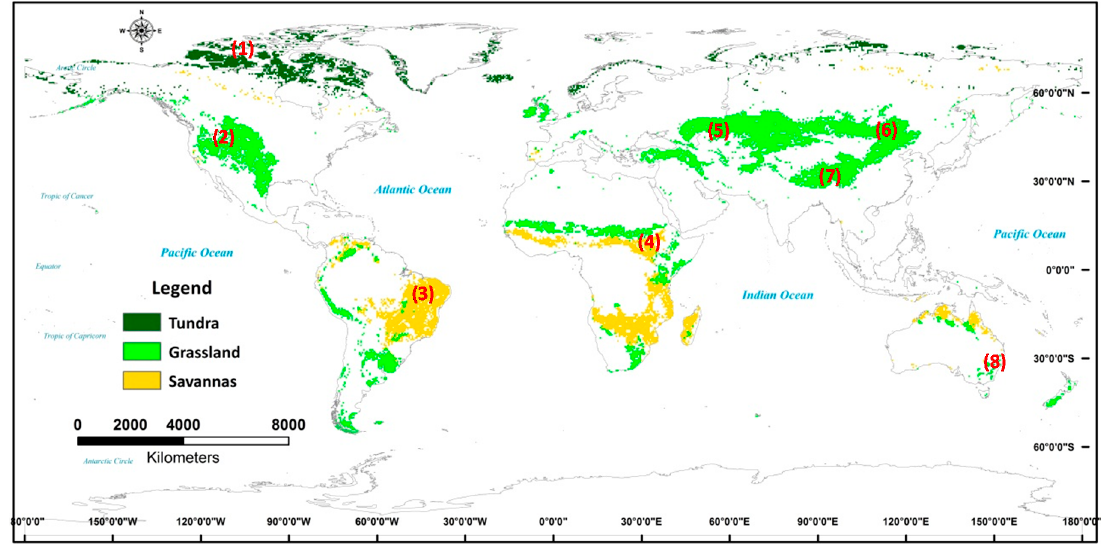
Figure 1. Global OGFD ecosystems distribution and regional division map. In this figure: ( 1 ) is the Arctic; ( 2 ) is the southwestern USA; ( 3 ) is mid-eastern South America; ( 4 ) is central Africa; ( 5 ) is central Eurasia; ( 6 ) is the Mongolian Plateau; ( 7 ) is the Qinghai-Tibetan Plateau; and ( 8 ) is Oceania.